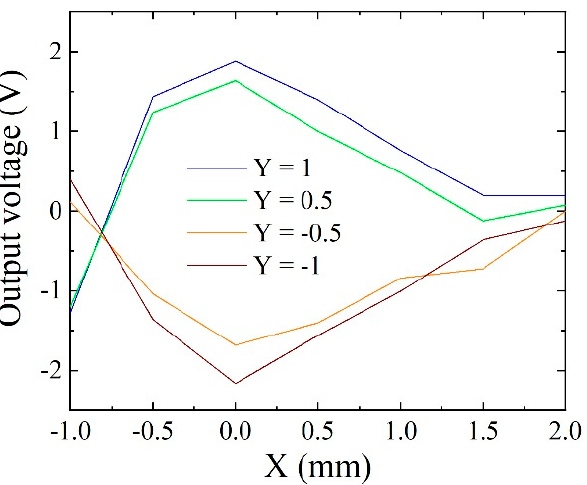
Figure 31. 2D-mapping of a measured signal, when a particle having a diameter of 200 µ m was scanned on the sensor element with the height of 1 mm. For the purpose of confirming the edge effect precisely, measurements of linearly scan along the X -axis on different Y-position as a parameter was carried out. Figure 32 is output profiles as a function of X-position. The Y-position was a parameter. The y = 1 and y = − 1 are the position of outer end strip of the meander sensor. The y = 0.5 and y = − 0.5 are at the middle of each meander sensor. The particle height was 1.5 mm in this case. This result also shows that the extreme value of sensor output appears at the edge of the sensor element, x = 0. It is confirmed the validity of the proposed estimation procedure of sensor impedance in case of the magnetic particle is placed in the vicinity of the thin film MI sensor element.